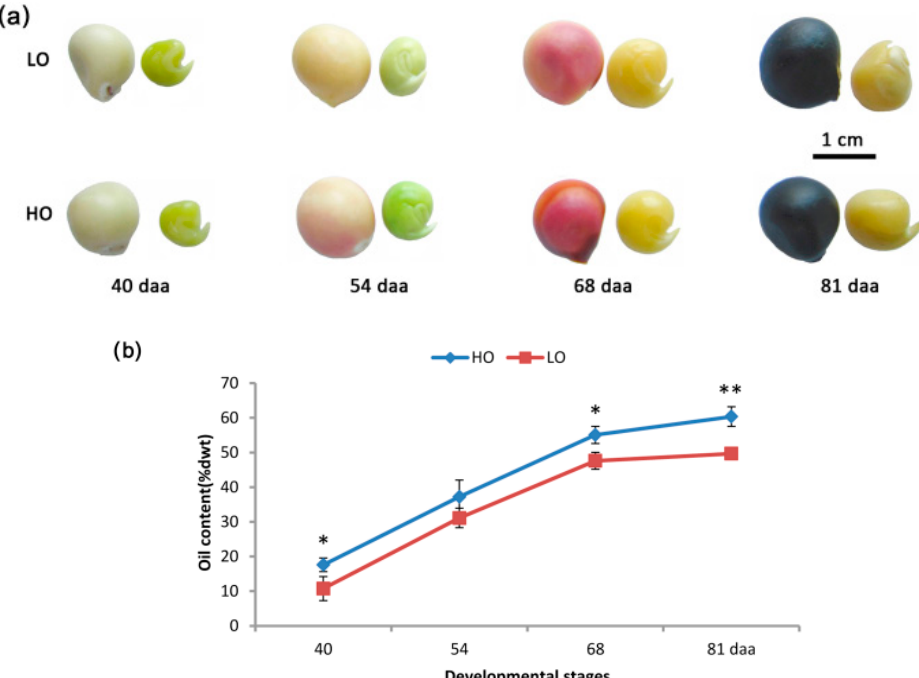
Figure 1. High-oil (HO) and low-oil (LO) yellow horn lines at four developmental stages. ( a ) HO and LO seeds and embryos; ( b ) HO and LO oil content. ** and * indicate significant differences in oil content between the two lines at the same development stage by t -test at p < 0.01 and p < 0.05. Error bars represent the SD for three independent measurements.